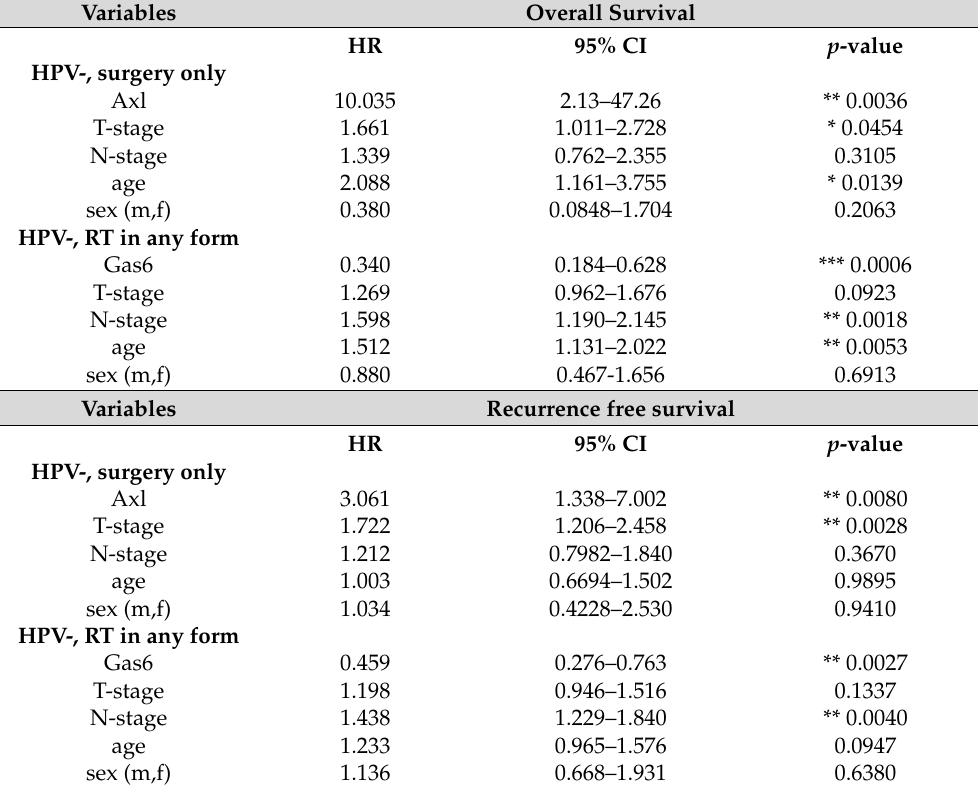
Table 2. Multivariable analysis. Asterisks indicate significant associations of variables and survival, with *, ** and *** indicating p < 0.05, p < 0.01, and p < 0.001, respectively (Cox proportional hazards regression). The table includes all tested variables of the respective analyses. Correlation analyses of the variables did not indicate meaningful associations in the respected subgroups, except for a weak association between T- and N-stage (not